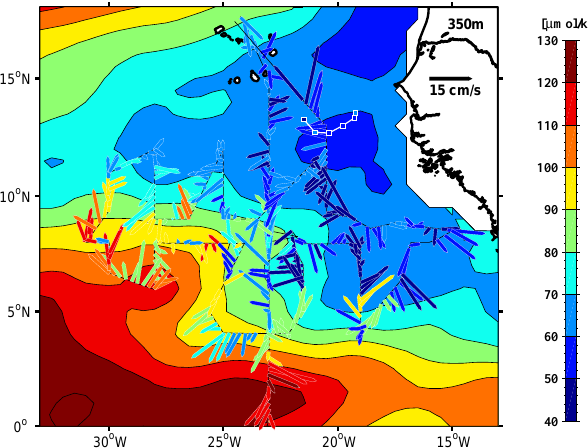
Figure 6. Horizontal distribution of ADCP velocity vectors con- verted to 350 m depth recorded in November and December 2009 with current vectors colored with oxygen (in µmolkg − 1 ) of the ac- companying CTD oxygen measurements at this depth. The oxygen distribution of the background field is from CARS 2009 climatology (Ridgway et al., 2002) for the mean of the November and December distribution at 350m depth. The float track (white line) and surfac- ing location (white squares) drifting at 350m depth and the oxygen measured by the float at 350m depth (color in the square) are shown for the months November and December